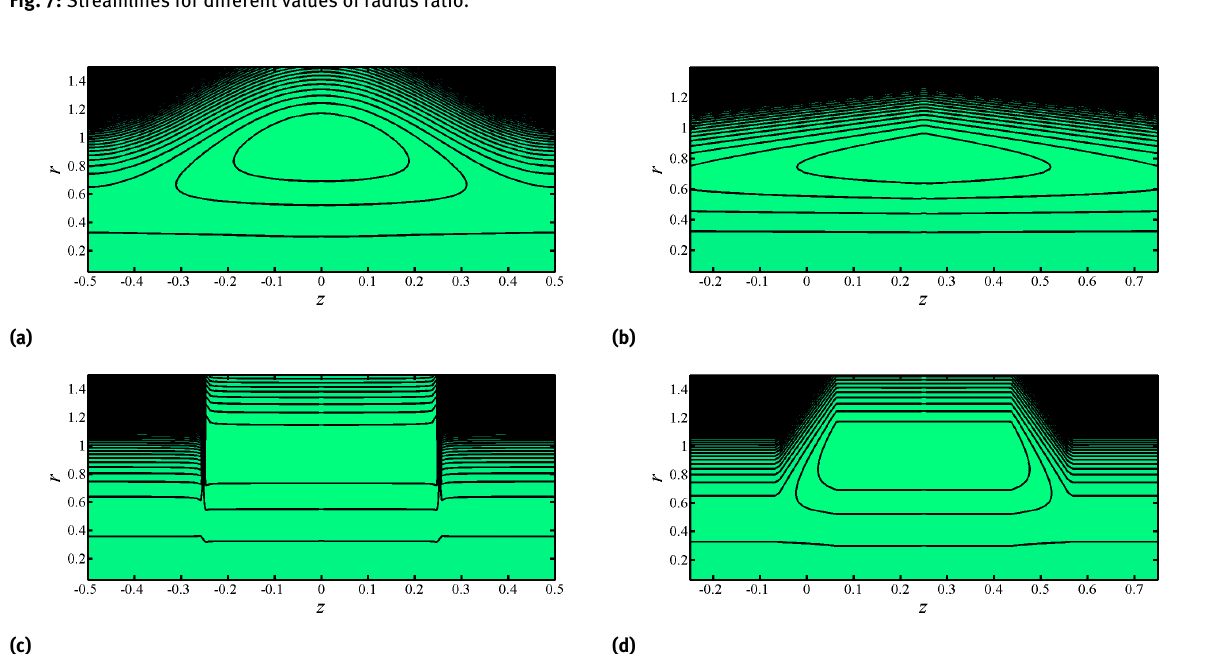
Fig. 8: Streamlines for different wave shapes such as, (a) Sinusoidal wave, (b) Triangular wave, (c) Square wave, (d) Trapezoidal